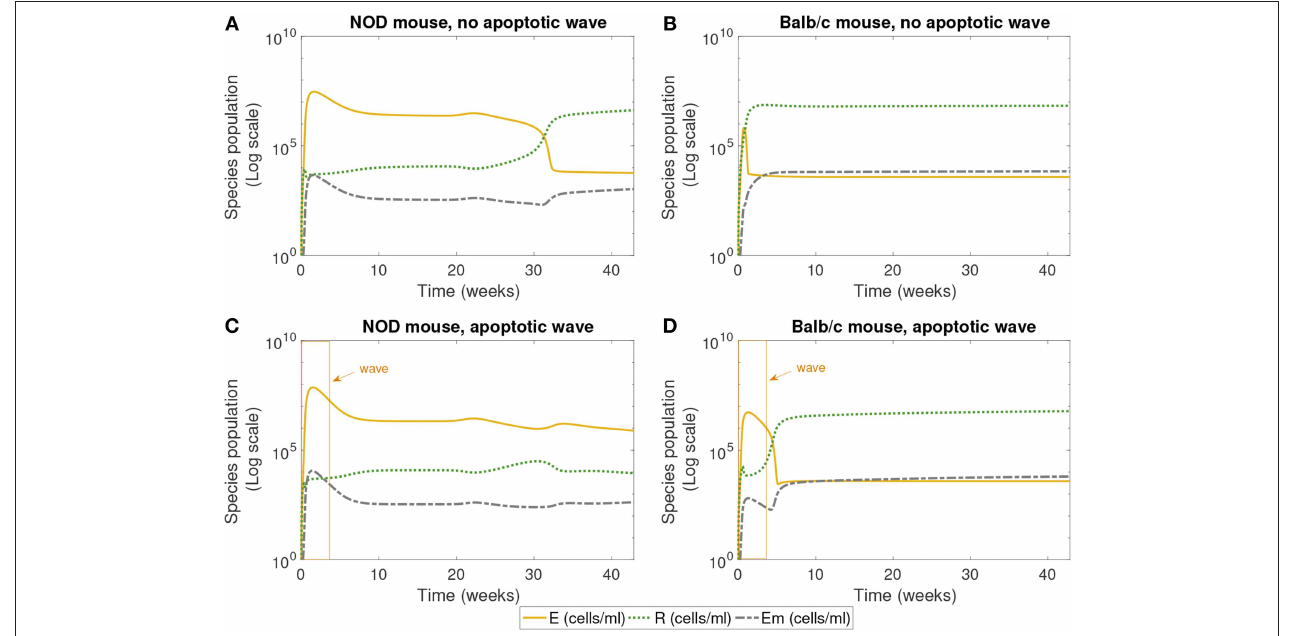
FIGURE 3 | The populations of effector ( E ), regulatory ( R ), and memory ( Em ) T cells simulated for 40 weeks, according to the single compartment mathematical model. We compared the system in the presence and absence of an early wave of apoptosis, and between NOD and Balb/c mice. The NOD mouse shows elevated effector T cells for large values of time in the presence of the apoptotic wave, an indicator of an autoimmune response, while the Balb/c mouse and the NOD without a wave have elevated regulatory T cells, a sign of immune homeostasis. (A) NOD mouse, no apoptotic wave, (B) Balb/c mouse, no apoptotic wave, (C) NOD mouse, apoptotic wave, and (D) Balb/c mouse, apoptotic